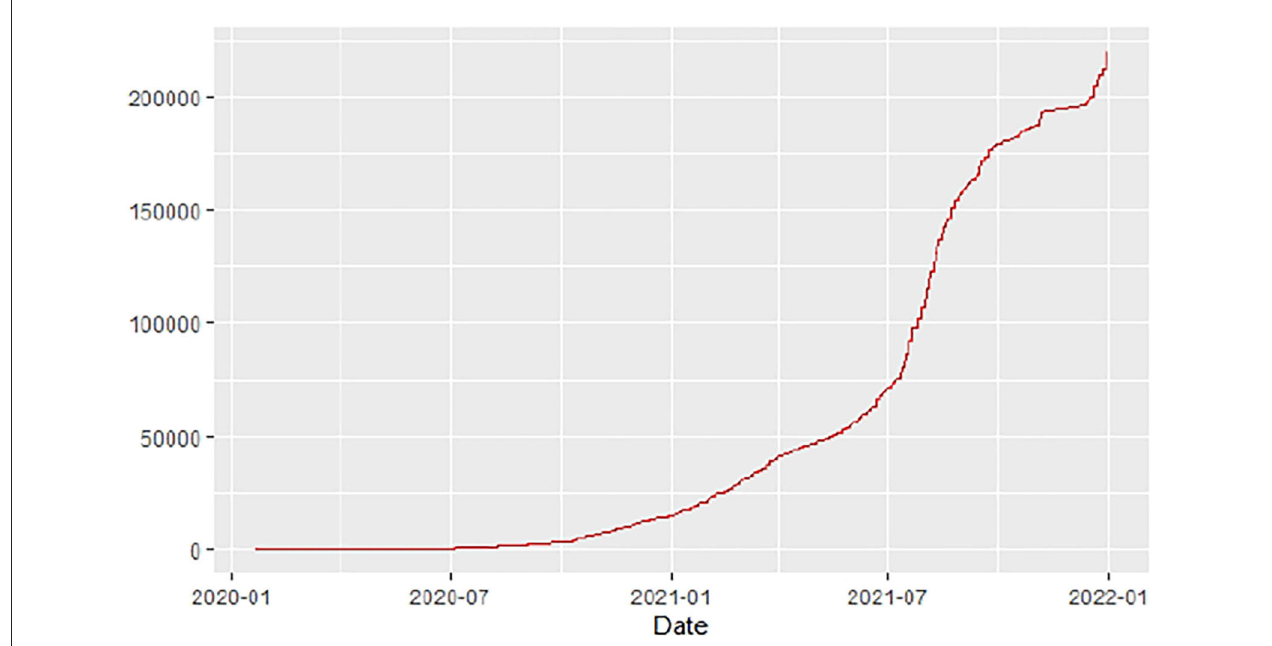
FIGURE 3 | Botswana cases.